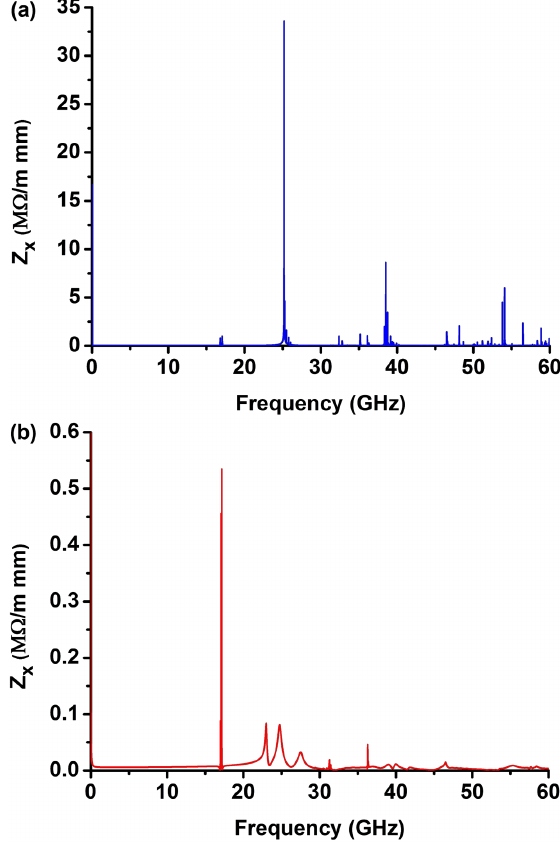
FIG. 7. Comparison of transverse wake potential impedances between PBG and DLW structures: (a) the transverse wake potential impedance in the DLW; (b) the transverse wake poten- tial impedance in the PBG [same as Fig.